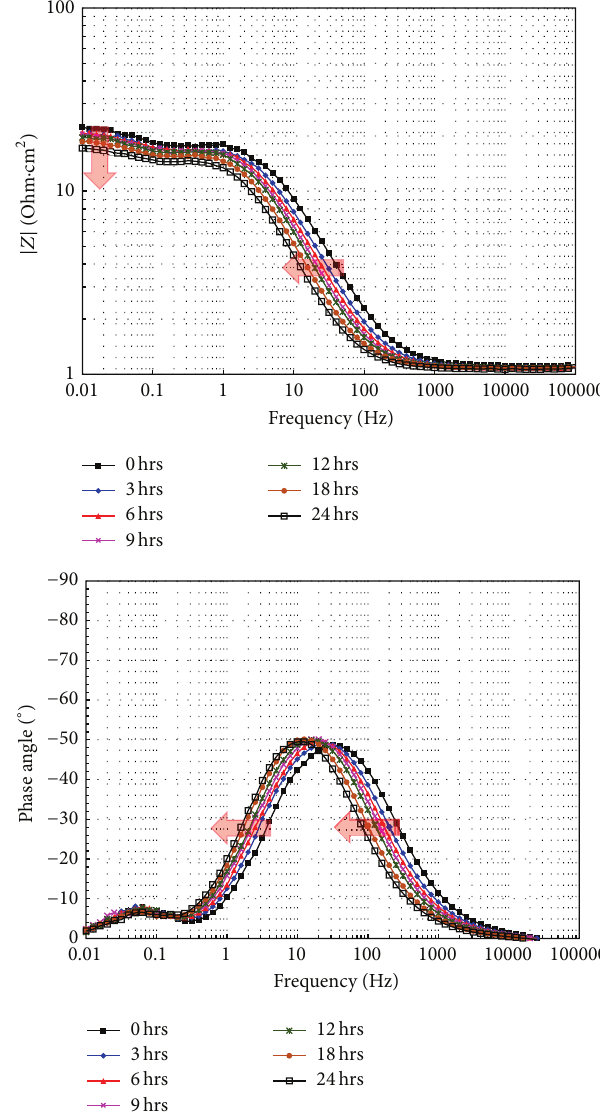
Figure 6: Nyquist and Bode plots for 1018 carbon steel in CO 2 - saturated (3% NaCl + 10% diesel) emulsion without inhibitors at 50 ∘